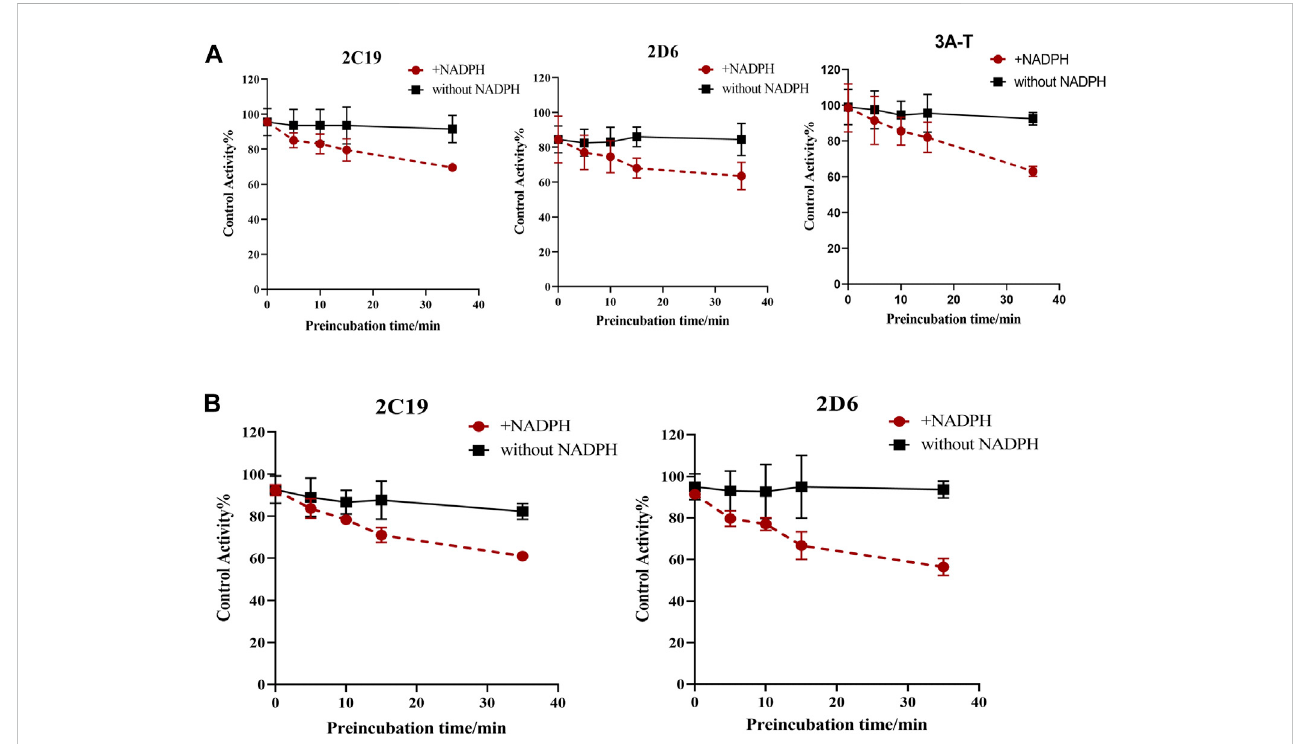
FIGURE 7 Effect of incubation time on the inhibition of CYP3A, CYP2D6 and CYP2C19, with SDEA (A) and Amento fl avone (B) . Note: 3A-T, CYP3A